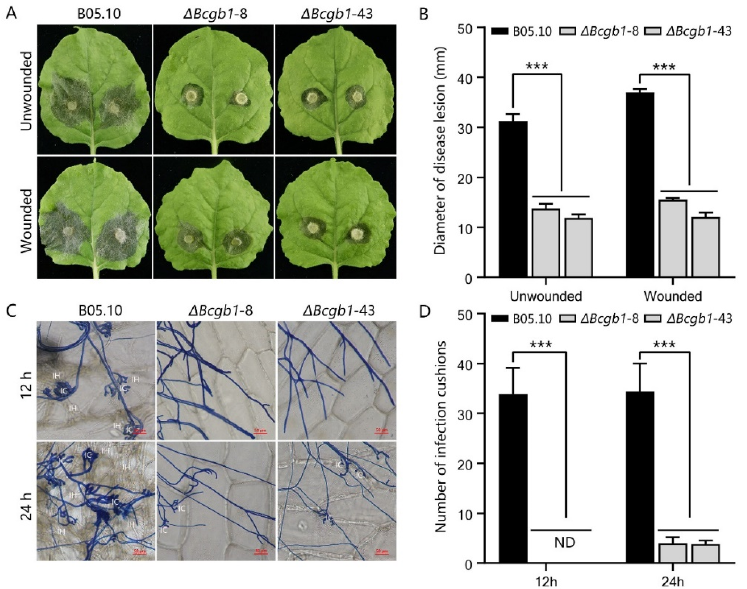
Figure 4. Bcgb1 is important for virulence in B. cinerea . ( A ) Pathogenicity test of the